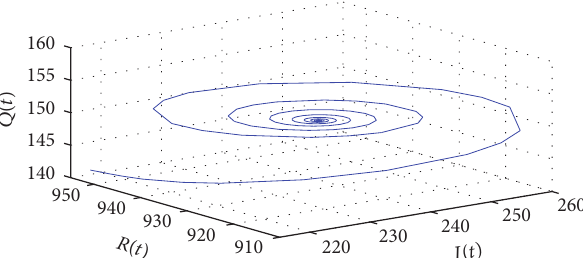
Figure 5: The projection of the phase portrait of system (69) in (𝑆, 𝐸,𝑉) -space with 𝜏 = 3.65 . 2